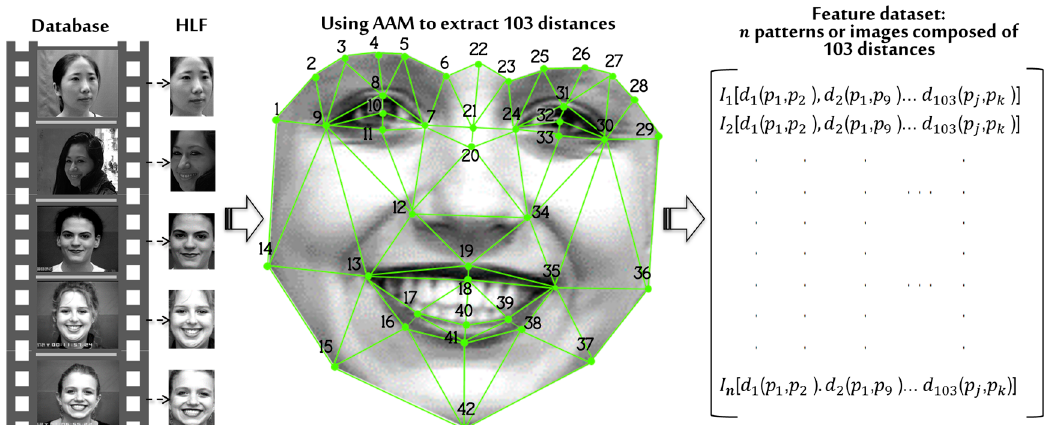
Figure 9. Dataset generated from the mesh resulting from the application of the active appearance model (AAM), where 42 points are located, from which 103 distances are generated for each processed face.